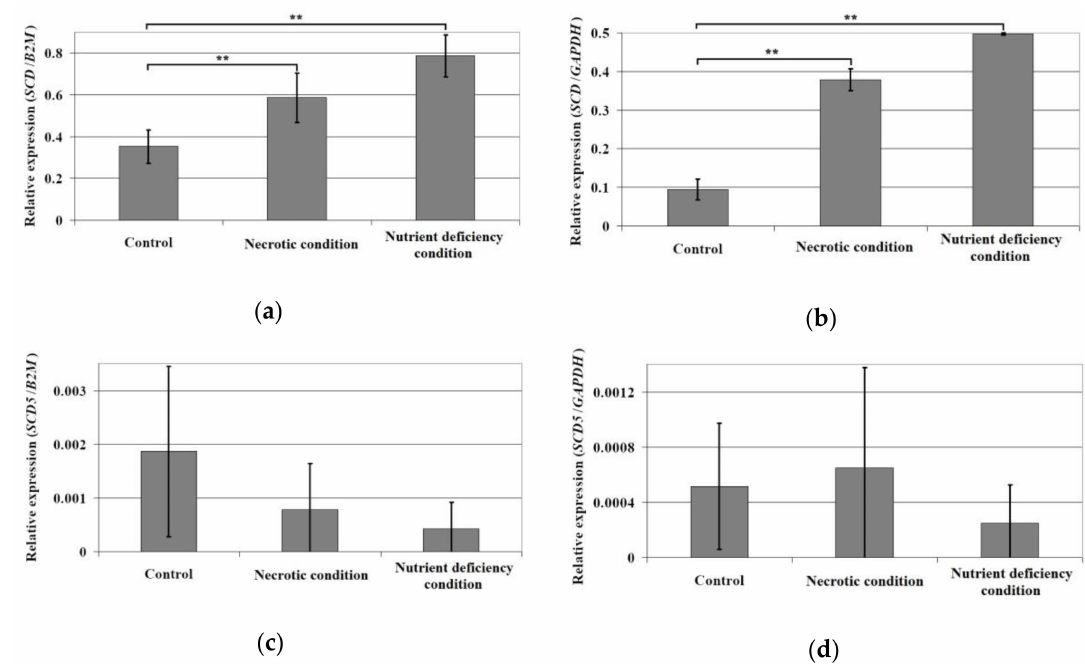
Figure 6. The e ff ect of necrotic condition or nutritional deficiency on the mRNA expression of SCD ( a , b ) and SCD5 ( c , d ). Human brain (glioblastoma astrocytoma) U-87 MG cell line cultured in eagle’s